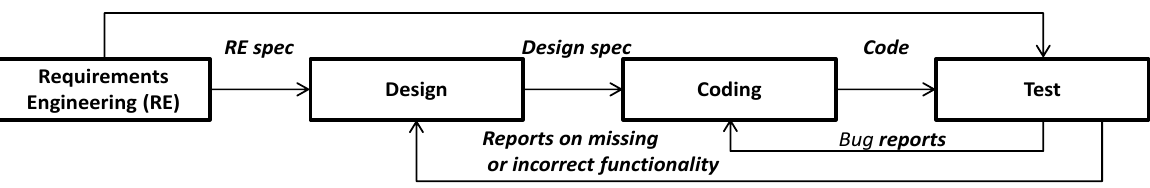
Figure 1. Simple model of a software project as a system (note that connections between the project and its environment are not